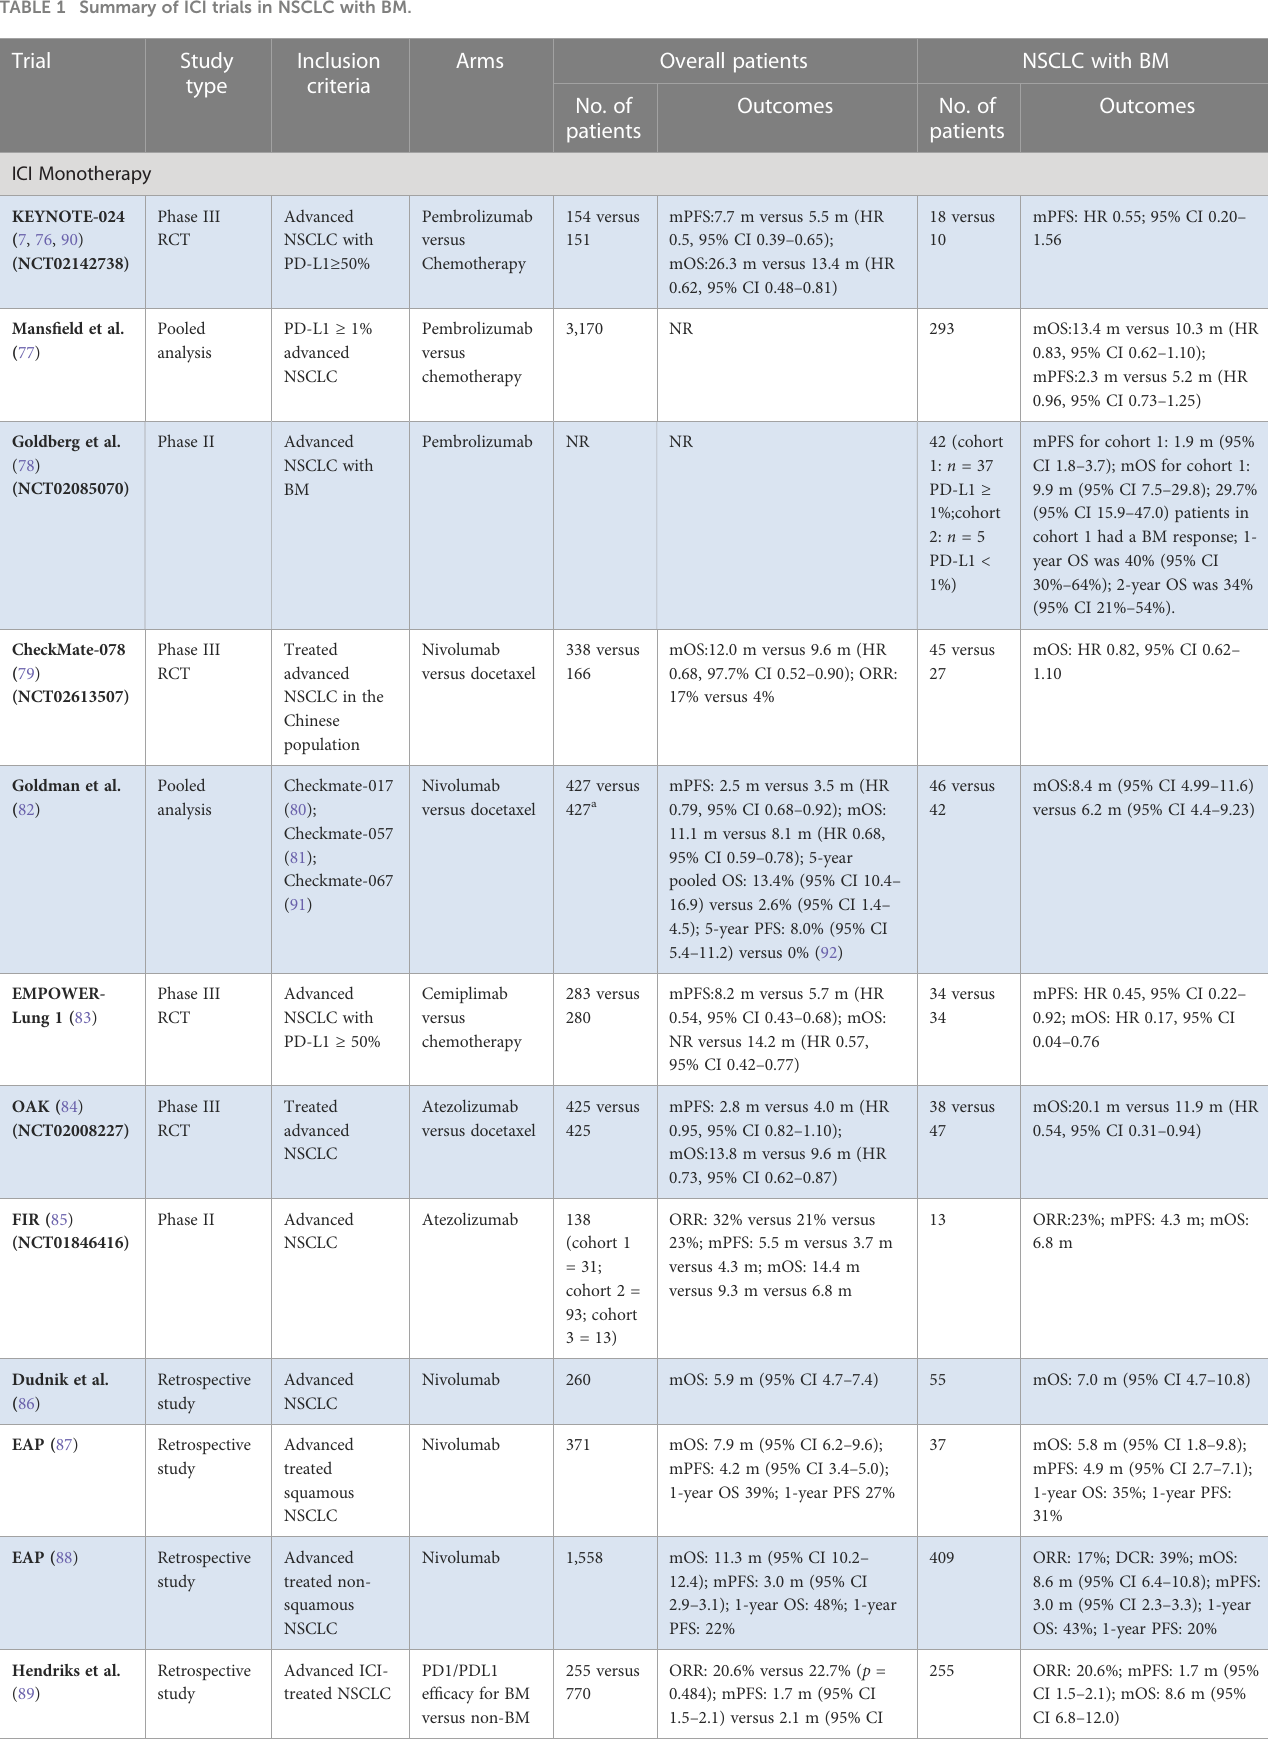
TABLE 1 Summary of ICI trials in NSCLC with